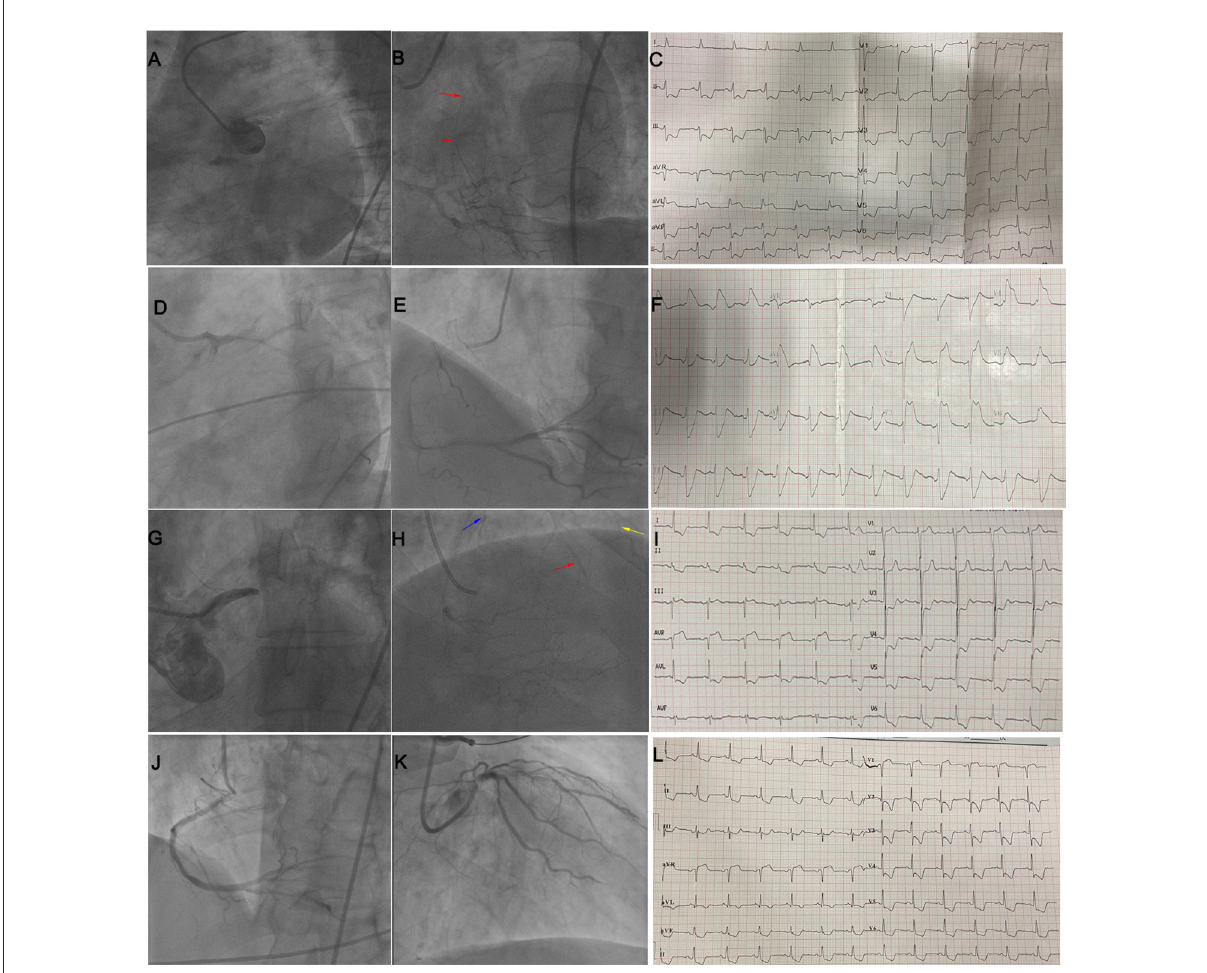
FIGURE5 (A–C) illustrate STE in both leads aVR and aVL in a patient with LM occlusion and collateral filling of LAD (red arrow). (D–F) illustrate STE in I, aVL, V2–V5 in a patient with subacute stent thrombosis in LM and no collateral circulation. (G–I) illustrate STE in lead aVR in a patient with LM occlusion and collateral filling of the LAD (red arrow), diagonal branch (yellow arrow), and LCX (blue arrow). (J–L) illustrate STE in leads aVR and V1 in a patient with subtotal LM occlusion and no collateral circulation. LM, left main; STE, ST-segment elevation; LAD, left anterior descending coronary artery; LCX, left circumflex